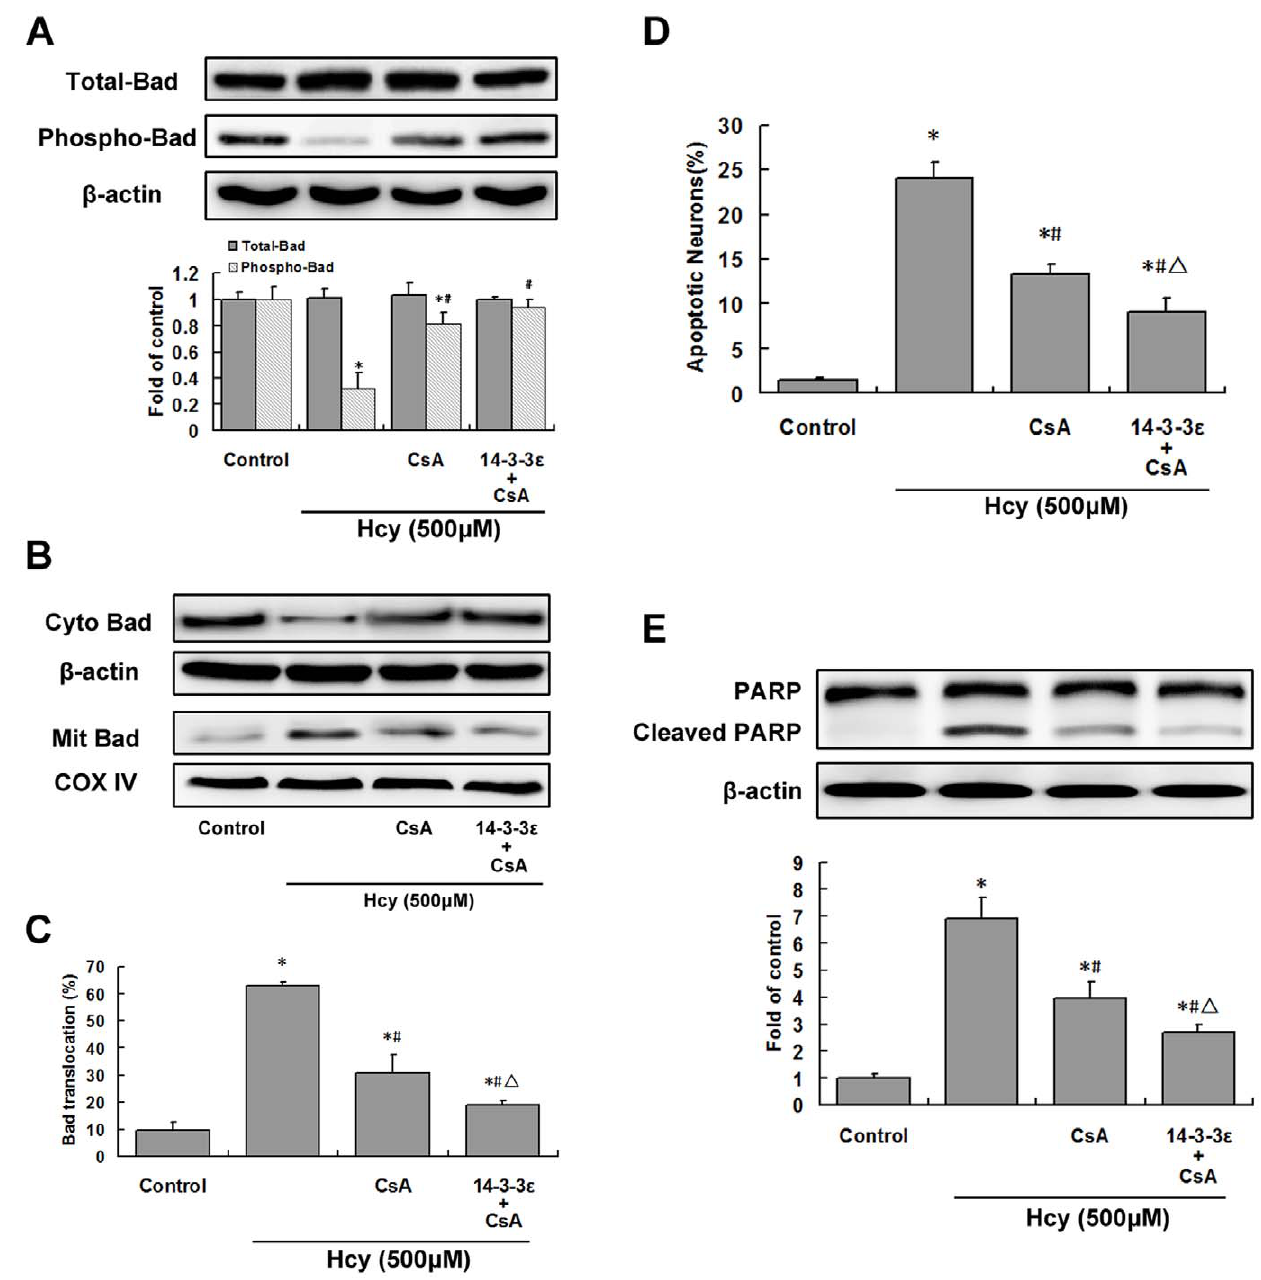
Figure 6. Calcineurin activation and 14-3-3 e suppression together contribute to Hcy-induced apoptosis. Hippocampal neurons transduced with lentiviral 14-3-3 e for 48 h were then pretreated with 1 m M CsA for 30 min before treatment with 500 m M Hcy ( Hcy ) for 24 h. A, Total Bad and phospho-Bad levels were assessed by western blotting and densitometric analysis. B, Western blot analysis of Bad in mitochondrial (Mit) and cytoplasmic (Cyto) fractions from hippocampal neurons. C, Percentage of total Bad (cytoplasmic + mitochondrial fractions) localized in the mitochondrial fraction as determined by densitometric analysis of the data from B. D, The level of apoptosis was determined by counting the number of neurons with apoptotic nuclei. Four randomly selected fields of Hoechst-stained cells were counted and the average percentage of apoptotic cells per total number of cells was determined. E, Cleaved PARP was measured using western blotting. * P , 0.05 vs. control. # P , 0.05 vs. Hcy treatment group. D P , 0.05 vs. CsA group. current results link the increase in Ca 2 + to activation of phosphorylated state at the mitochondria surface, where it appears calcineurin, which in turn dephosphorylates Bad to stimulate its to neutralize the anti-apoptotic effects of Bcl-2 and Bcl-xL translocation to mitochondria. The subcellular location of Bad is [26,27,28]. As downstream events after Bad dimerization with controlled by its phosphorylation status. It exists in a phosphory- Bcl-xL, Bax translocation to mitochondria and cytochrome c lated state in the cytoplasm, bound to 14-3-3, and in a non-